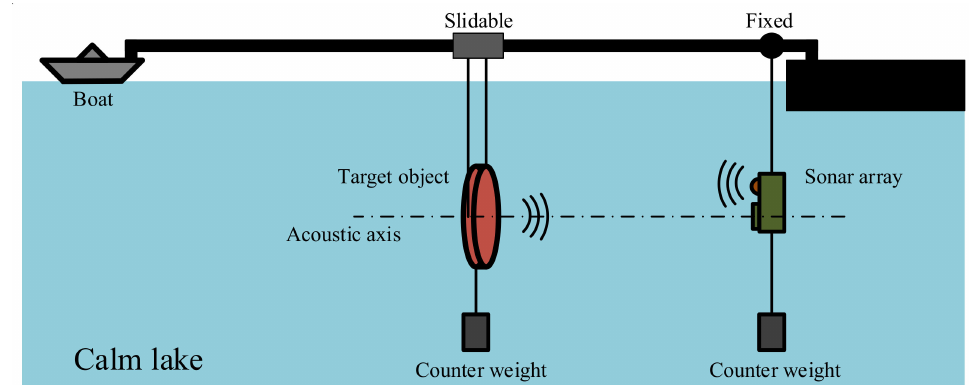
Figure 26. Schematic diagram of underwater positioning